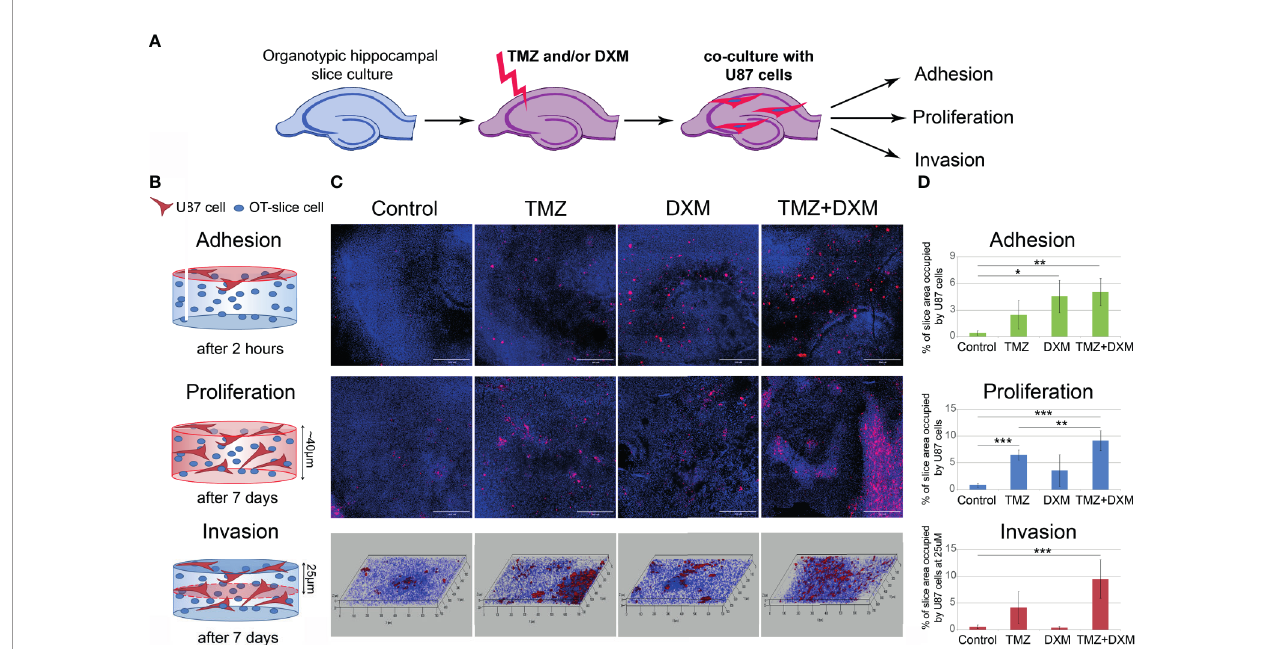
FIGURE 1 | Effects of TMZ and/or DXM-induced changes in brain organotypic slices on adhesion, proliferation and invasion of GBM cells ex vivo . (A) Scheme of the experiment. (B) Methodology for detection of the studied parameters. (C) Confocal microscopy of U87-RFP cells seeded on the control and TMZ/DXM-treated organotypic brain slices. Cells nuclei are stained with DAPI. Magni fi cation, ×200, scale bar 500 µm. (D) Quantitative analysis of the U87-RFP cells on the control and treated rat brain tissues. ANOVA and post-hoc Fisher ’ s LSD test, *p < 0.05, **p < 0.01, ***p < 0.001. TMZ, temozolomide; DXM,